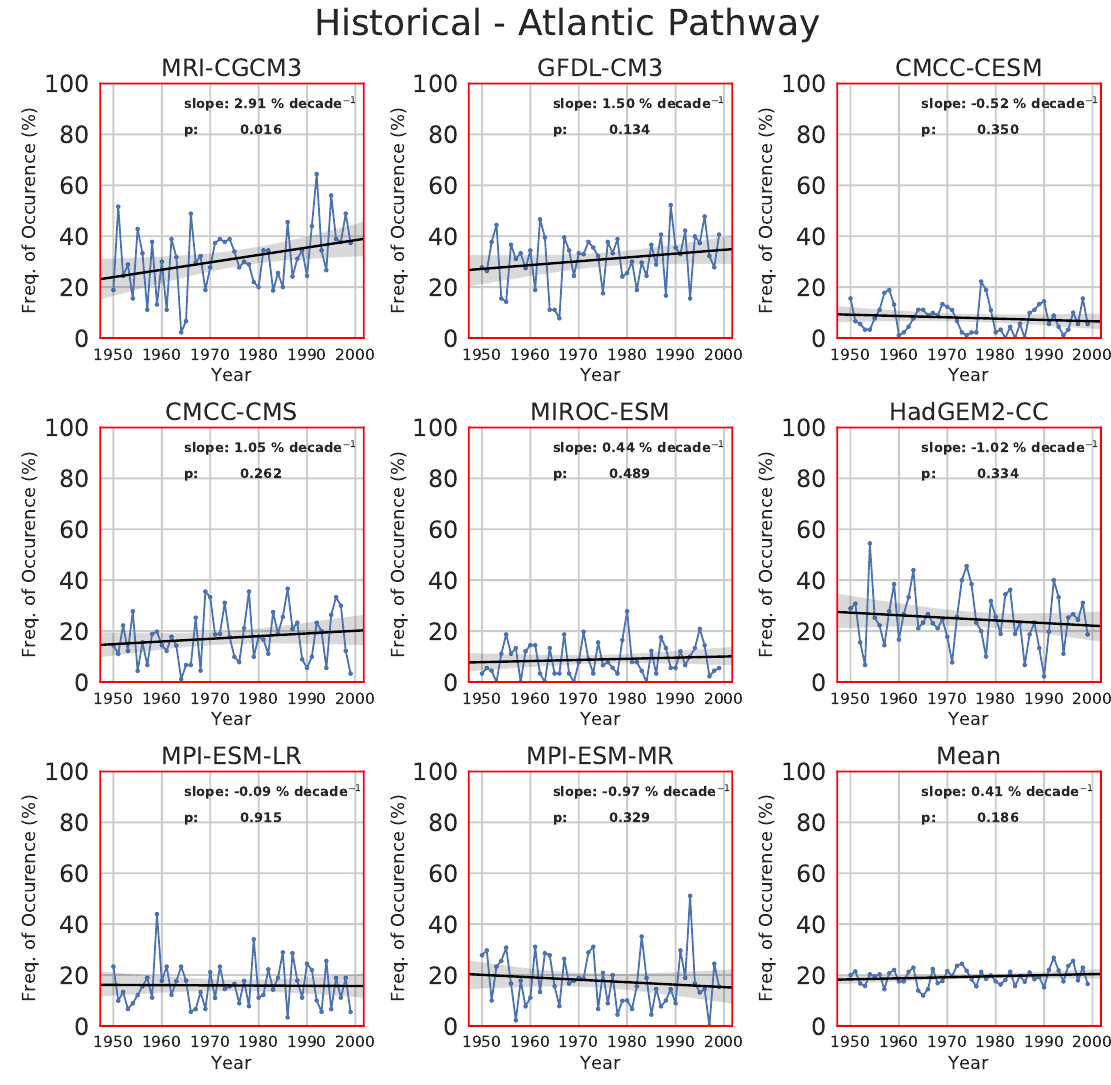
Figure 8. Relative occurrence frequencies for the Atlantic pathway for each model and a multi-model mean derived for each winter (blue line) of the historical time frame (1950 to 1999). The linear trend is shown as black line, and greyshading shows the 95% confidence intervals for the trends derived by bootstrap resampling. p values are shown according to a two-sided t